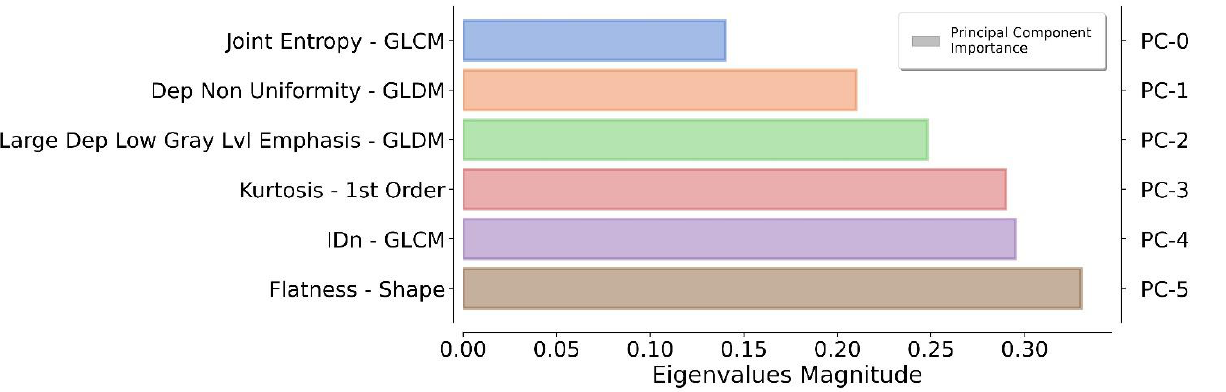
Table 3. The results obtained by the proposed pipeline regarding 500 different 10-fold cross valida-